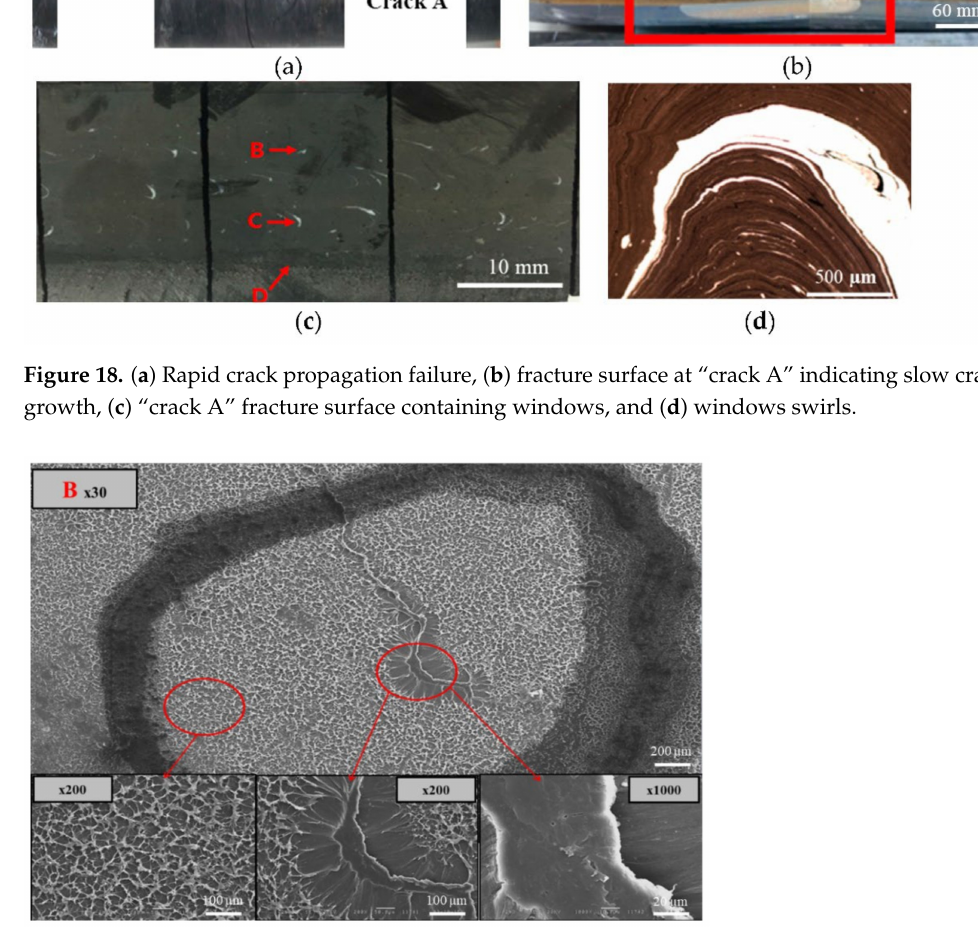
Figure 19. SEM photomicrographs of the fracture surface of the window and black compound regions (region B in Figure